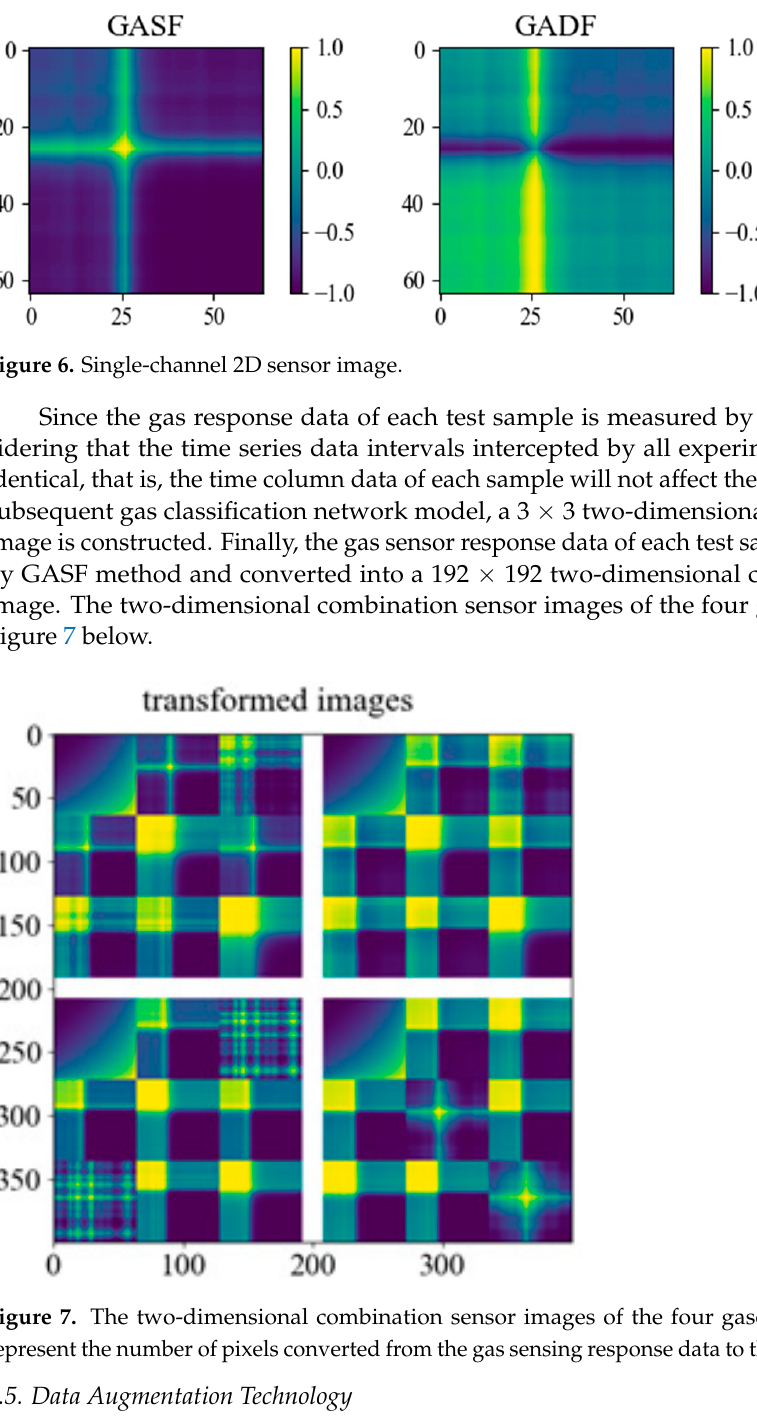
Figure 6. Single-channel 2D sensor image.